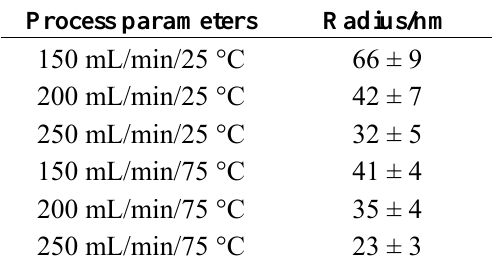
Table 3. Particle size determined using dynamic light scattering.